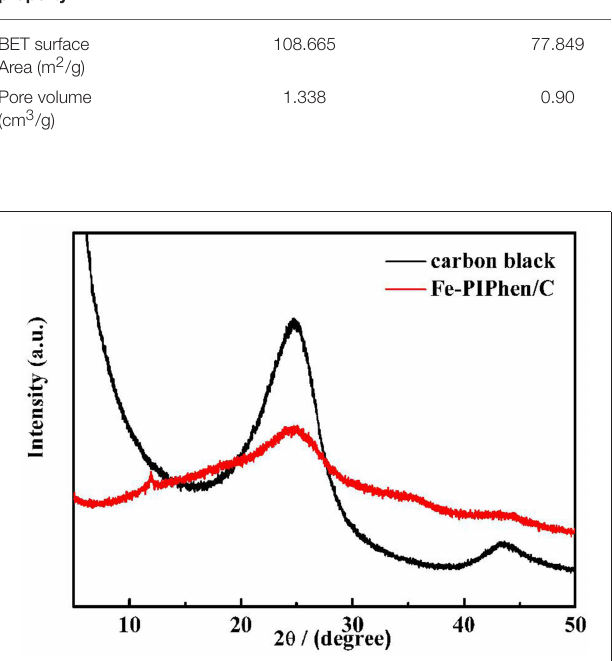
FIGURE 4 | PXRD test curves of Fe-PIPhen/C and carbon black (Vulcan XC-72).